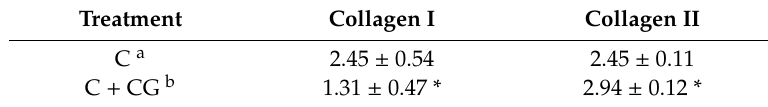
Figure 4. Immunohistochemical analysis of human chondrocytes exposed to a chondrogenic medium (C) or to a chondrogenic medium and CG 1 mg / mL (C + CG). Avidin-biotin detection method. Bar = 100 µ m. When chondrocytes were exposed to the chodrogenic medium only, type-I and type-II collagen expression were not significantly di ff erent; when they were also exposed to CG 1.0 mg / mL, expression of type-I collagen was inhibited, and that of type-II collagen enhanced. * p ≤ 0.05. Table 2. Data from immunohistochemical analysis of COL-1 and COL-2 production.